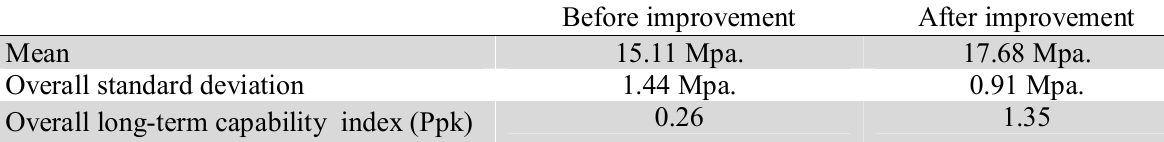
Fig. 6. Comparative process capability plots of the MOR before and after improvement. Table 7 Comparative results of process capability before and after improvement Before improvement